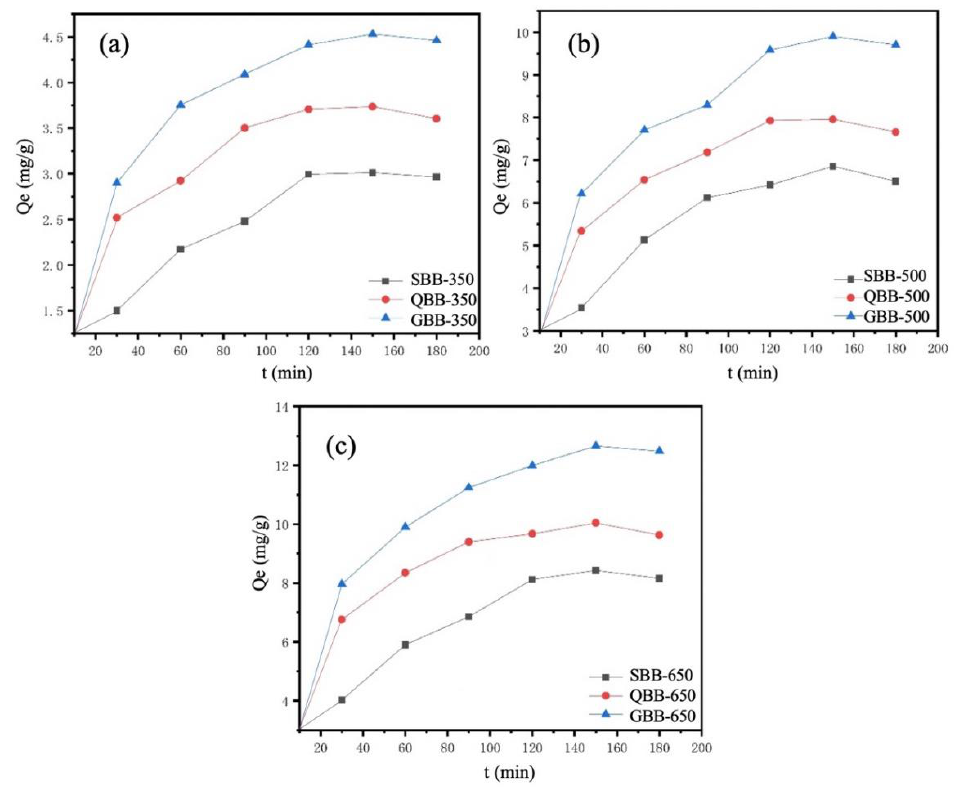
Figure 3. Experimental results of adsorption kinetics of three biochar at different preparation tem- peratures: ( a ) Cd 2+ adsorption curves of GBB, QBB, and SBB at 350 °C; ( b ) Cd 2+ adsorption curves of atures: ( a ) Cd 2+ adsorption curves of GBB, QBB, and SBB at 350 ◦ C; ( b ) Cd 2+ adsorption curves of GBB, QBB, and SBB at 500 °C; ( c ) Adsorption curves of Cd 2+ at 650 °C for GBB, QBB, and SBB. GBB, QBB, and SBB at 500 ◦ C; ( c ) Adsorption curves of Cd 2+ at 650 ◦ C for GBB, QBB, and